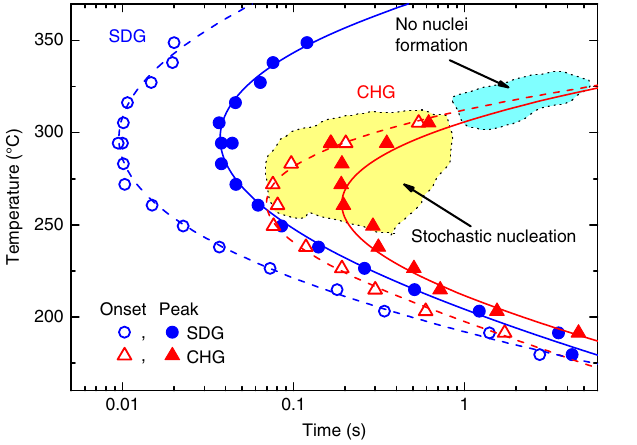
Fig. 6 Time – Temperature – Transformation diagram. TTT diagram of crystallization after heating from the glassy phase at a rate of 30,000 K s − 1 . The glasses SDG and CHG were formed after cooling at two different rates: 500 K s − 1 (to generate an SDG) and 20,000K s − 1 (to generate a CHG). Un fi lled symbols represent the onset times, and fi lled symbols represent the peak times of crystallization. The region marked in yellow illustrates stochastic nucleation of the CHG, and that in light blue illustrates the complete lack of nuclei formation in the timeframe of 5 s isothermal holding (see Supplementary Fig. 3)